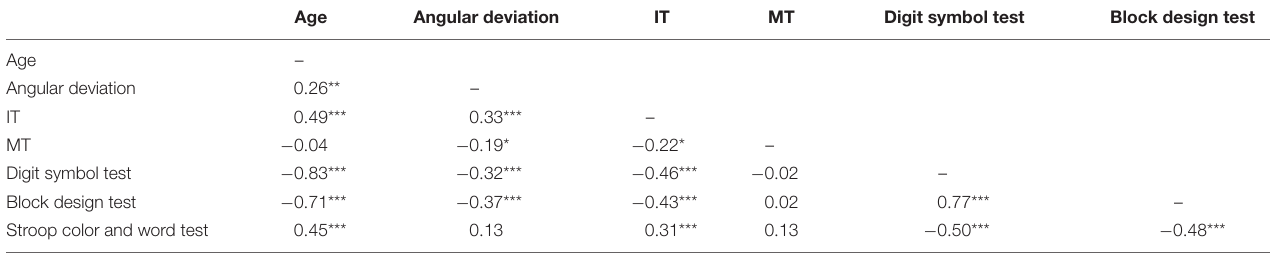
TABLE 2 | Correlations between visuomotor adaptation, kinematics, and cognitive functions.